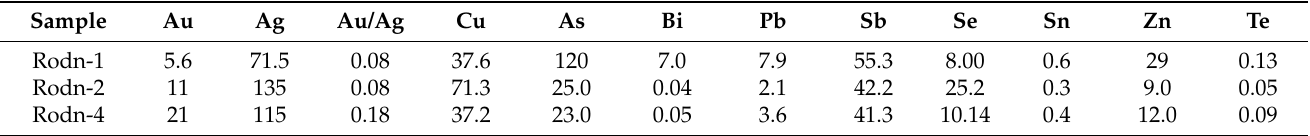
Table 1. Whole-rock concentration of ore and chalcophile elements of 3 samples from the Rodnikovoe deposit, ppm.